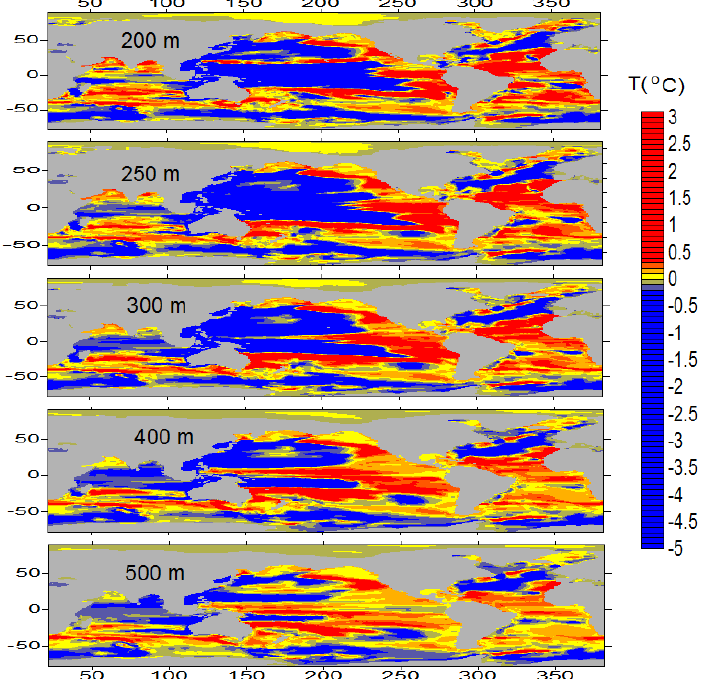
Figure 6. Perturbations in the WO temperature (°C) in the part of the active upper layer related to the main thermocline (levels 200, 250, 300, 400, 500 m) from the phase of 1948–1974 to the phase of 1975–1999.